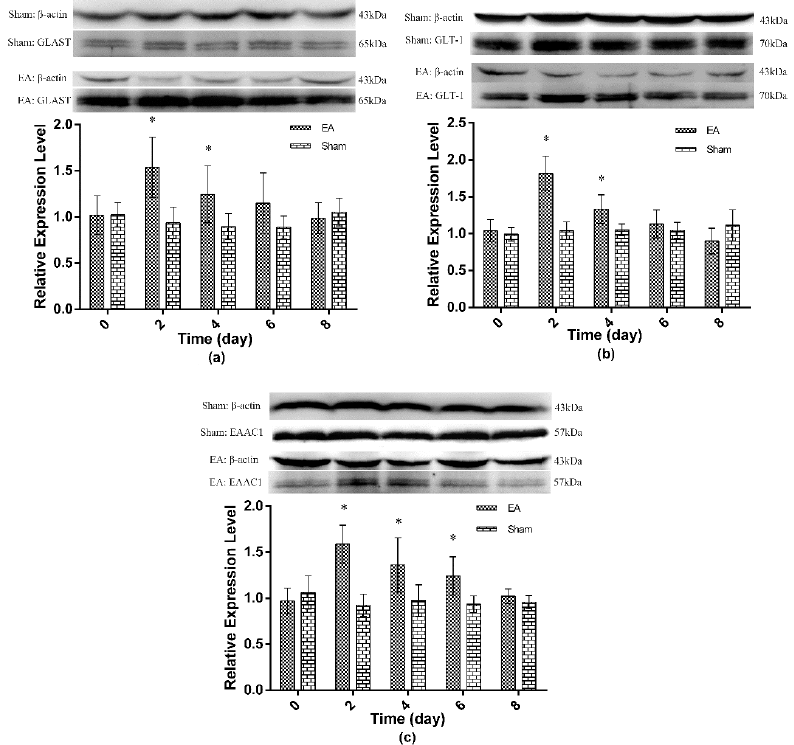
Figure 4. The protein expression levels of the spinal GTs after repeated EA (Mean ± SD, n = 6). Rats were given EA once daily for eight consecutive days. Rats in the sham group were treated the same as EA group but without electricity. Samples were collected from the L4-5 segment of the spinal cord at 2 h (for EAAC1) or 4 h (for GLAST and GLT-1) immediately after the last EA or sham treatment. ( a ) GLAST expression; ( b ) GLT-1 expression; ( c ) EAAC1 expression. The significance of differences was calculated by a t -test. * p < 0.05 compared with sham group within the same day.